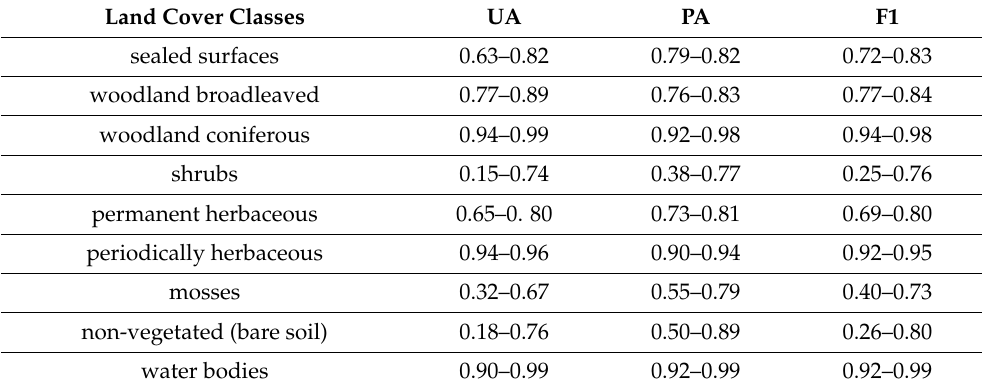
Table 4. The user’s (UA), producer’s (PA) accuracy and F1 score for land cover classes in the flat classification (calculated on six Sentine-2